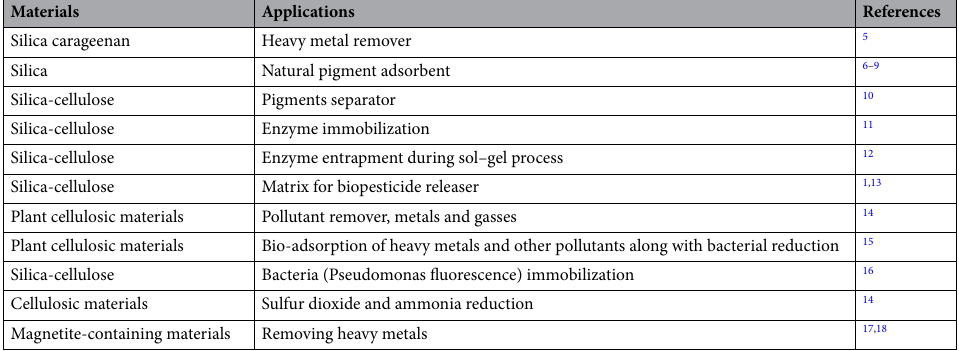
Table 1. Some silica/alumina/cellulosic materials and their applications.